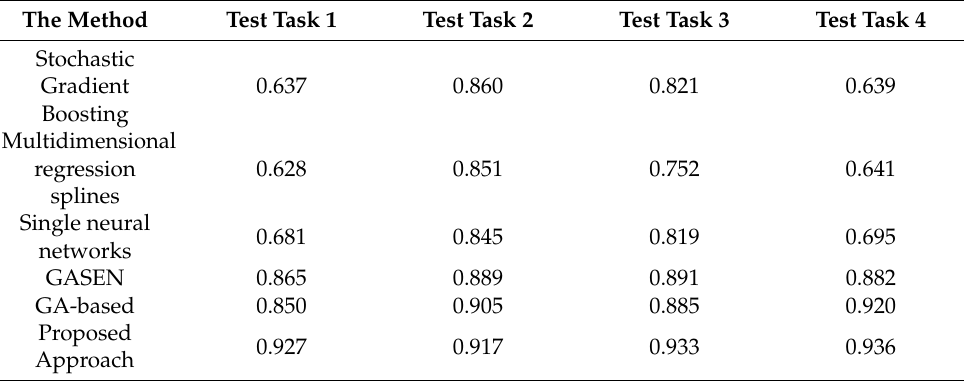
Table 4. Data on the results of the study of methods on test problems with additive noise